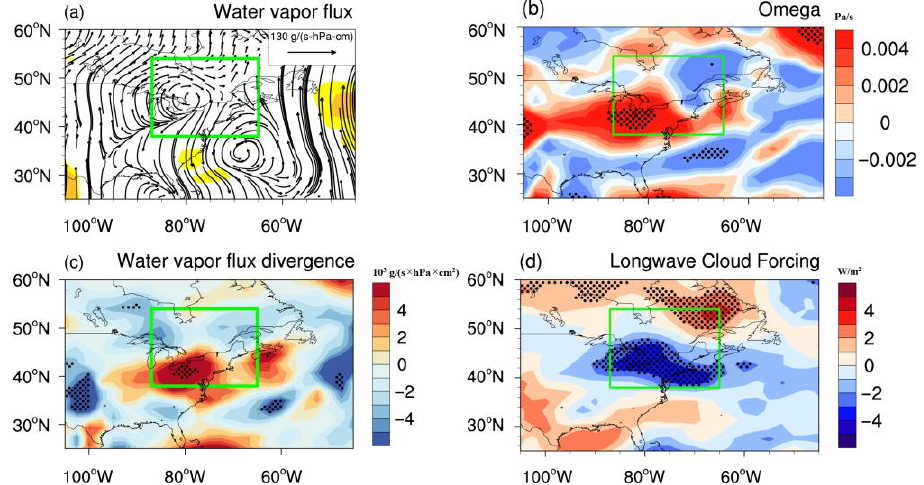
Figure 9. ( a – c ) Same as Figure 6a – c, but for the differences between experiments E3 and E2. Meridional water vapor flux components in ( a ) are multiplied by 5. ( d ) Long wave cloud forcing (W/m 2 ) between experiments E3 and E2. Black dots denote regions where differences are significant at the 90% confidence level. The experiments are based on WACCM4.